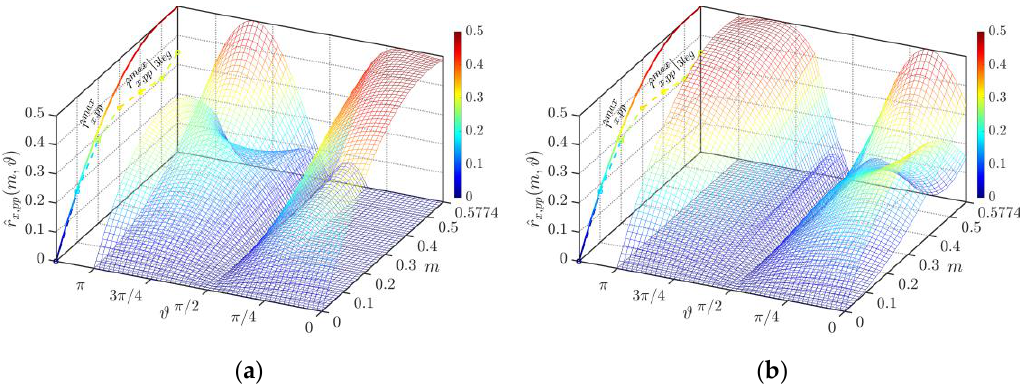
Figure 17. Normalized primary and secondary peak-to-peak phase current ripples in case of: ( a ) DPWMMAX; ( b ) DPWMMIN.